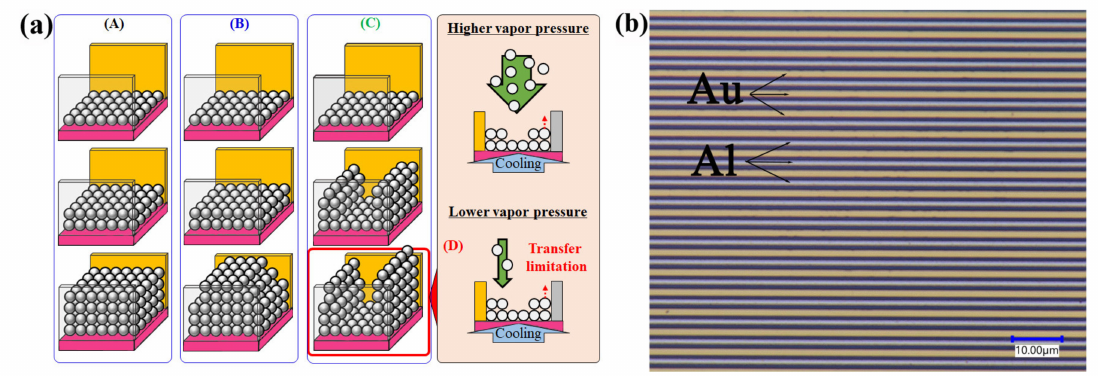
Figure 7. ( a ) Scheme showing the probable reasons for the di ff erence in output current as a function of cooling rates at di ff erent vapor pressures and ( b ) an optical micrograph of the sensor’s surface with a 0.5 mm gap between the electrodes at 70% RH near the sensor’s surface.